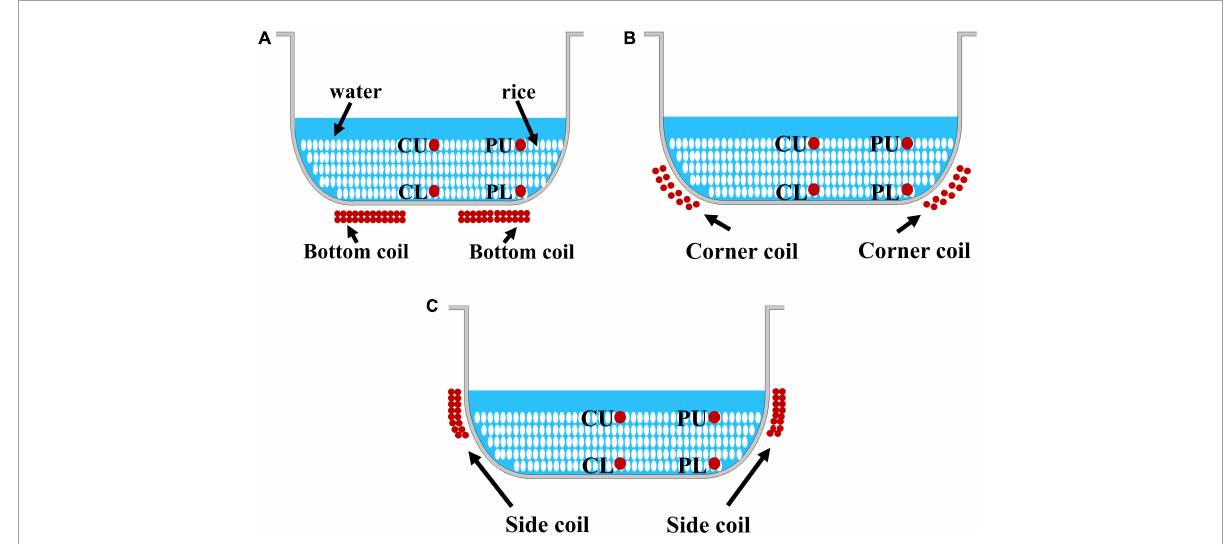
FIGURE1 Schematics of different heating modes and sampling points. (A) Mode 1. (B) Mode 2. (C) Mode 3. CU, central upper layer; PU, peripheral upper layer; CL, central lower layer; and PL, peripheral lower